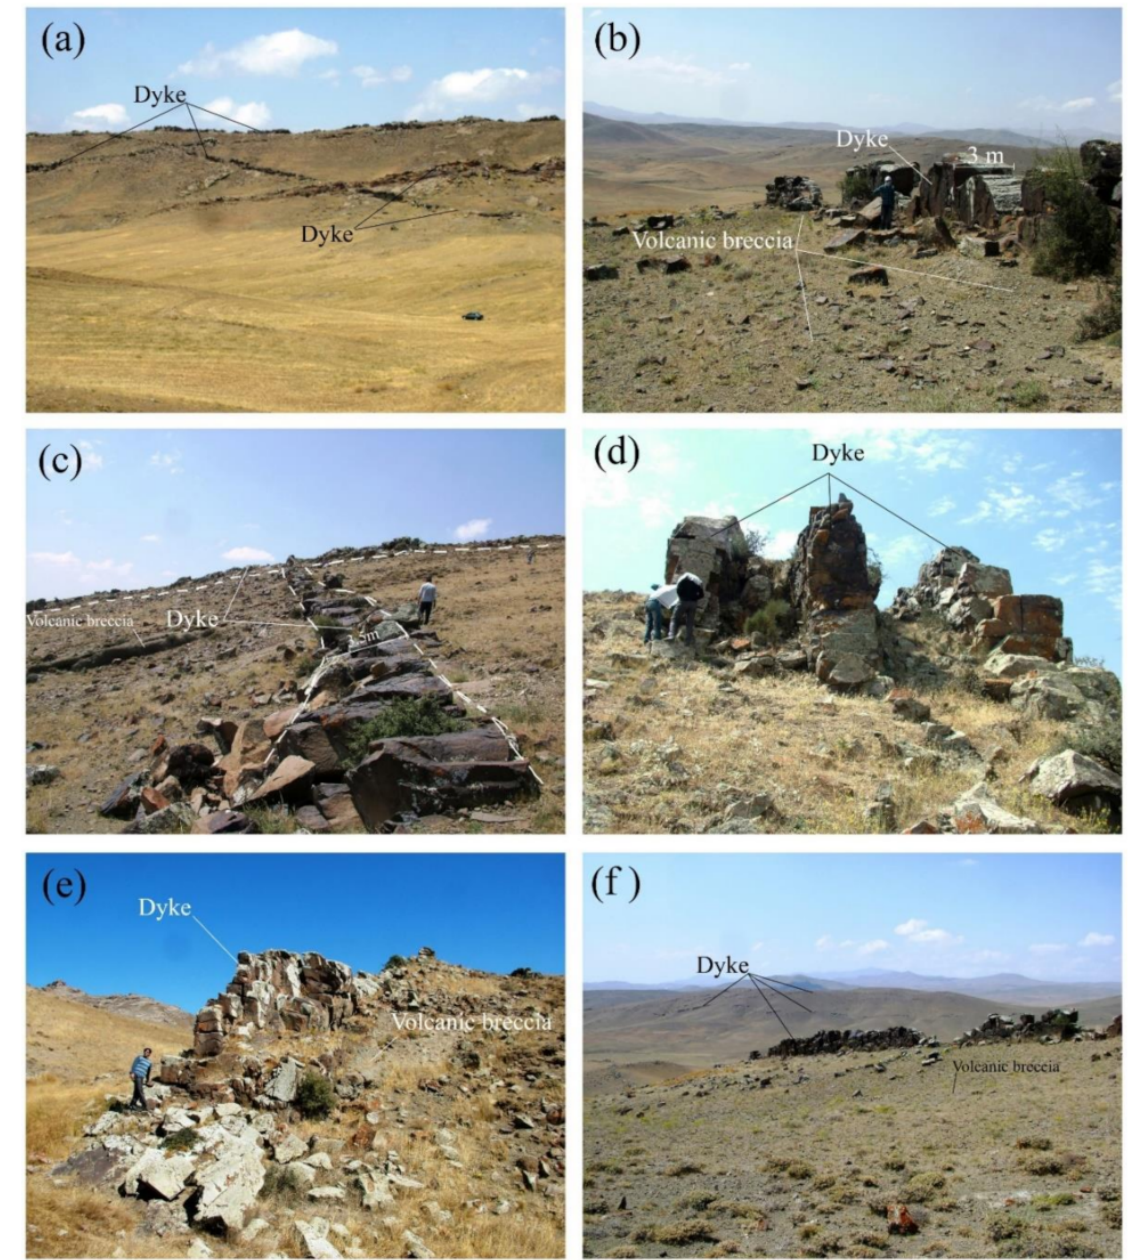
Figure 3. Outcrop photos of dykes and their host volcanic breccia. ( a ) Crossed tephritic dykes intruded into the north of the study area. ( b ) A basaltic dyke intruded in the volcanic breccia in the west of the study area. ( c ) A NE–SW tephritic dyke cuts across a NW–SE dyke in the east of study area. ( d ) Three tephritic dykes intruded in the volcanic breccia with along a parallel NW-SE strike. ( e ) An andesitic dyke with a width of 5 m in the northern region. ( f ) Some tephritic and basaltic dykes that outcrop in the study